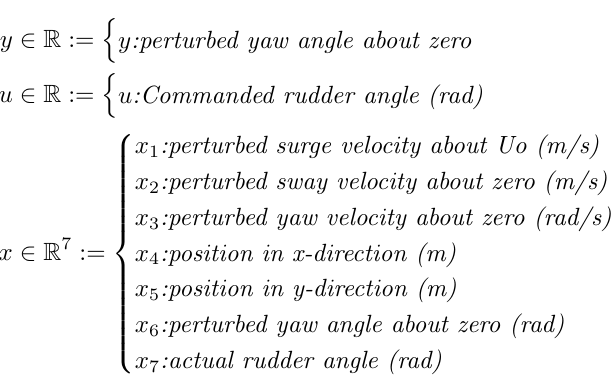
Figure 14: Trade-off curves for performance vs. robust- = 9 . 06 Compar- = 2 . 17 IAE o ness. IAE o vu vy ing the proposed δ -tuning and SIMC vs. the POI-PID controller on the process model as in Eq. (47).